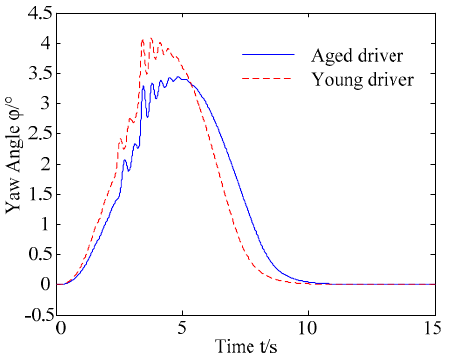
Figure 23. Yaw angle of vehicle p under different handling characteristics. Sensors 2020 , 18 , x FOR PEER REVIEW